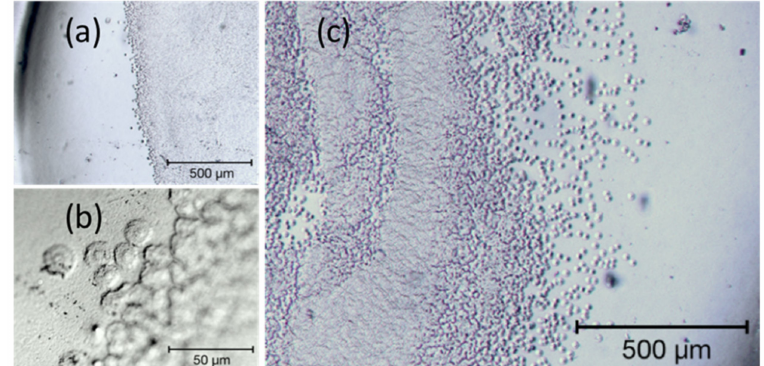
Figure 3. Selected areas of the explanted IOLs’ surface in bright-field microscopy. ( a , c ) shows two di ff erent partially sedimented regions of the lens surface, ( b ) magnified edge of the sedimentation with well-defined round shaped sediments.